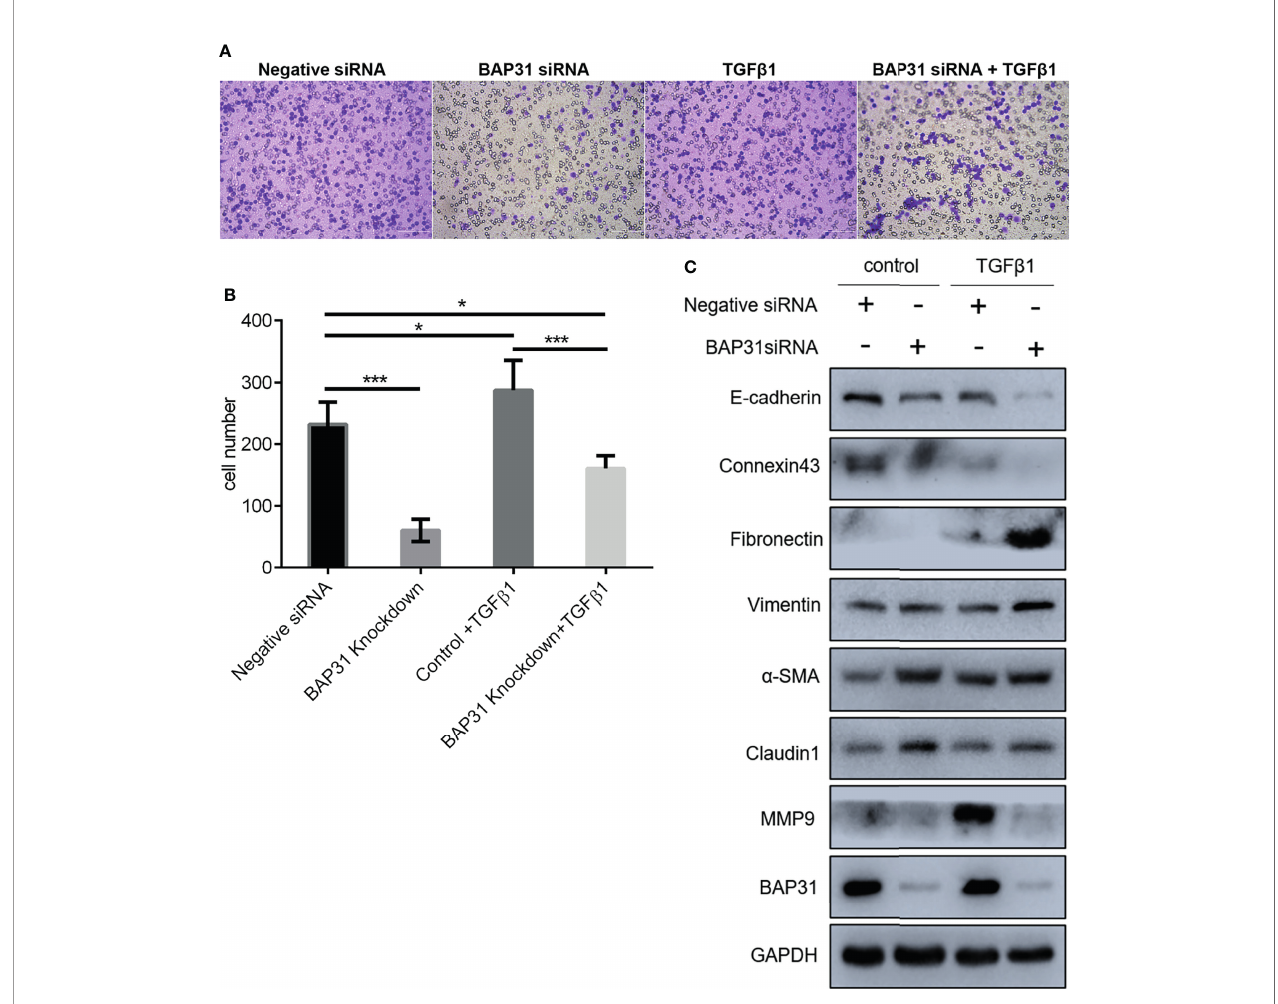
FIGURE 5 | Migration of A549 lung cancer cells with combinatorial treatment of BAP31 siRNA and TGF b . (A) Cell migration was examined by the trans-well assay. Cells that had undergone migration were stained with 0.1% crystal violet. (B) Statistics on the average migrated cell number in trans-well assay (mean ± SEM of duplicate experiments). * p < 0.05 versus control and *** p < 0.001 versus control. (C) Protein expression as determined by Western blot